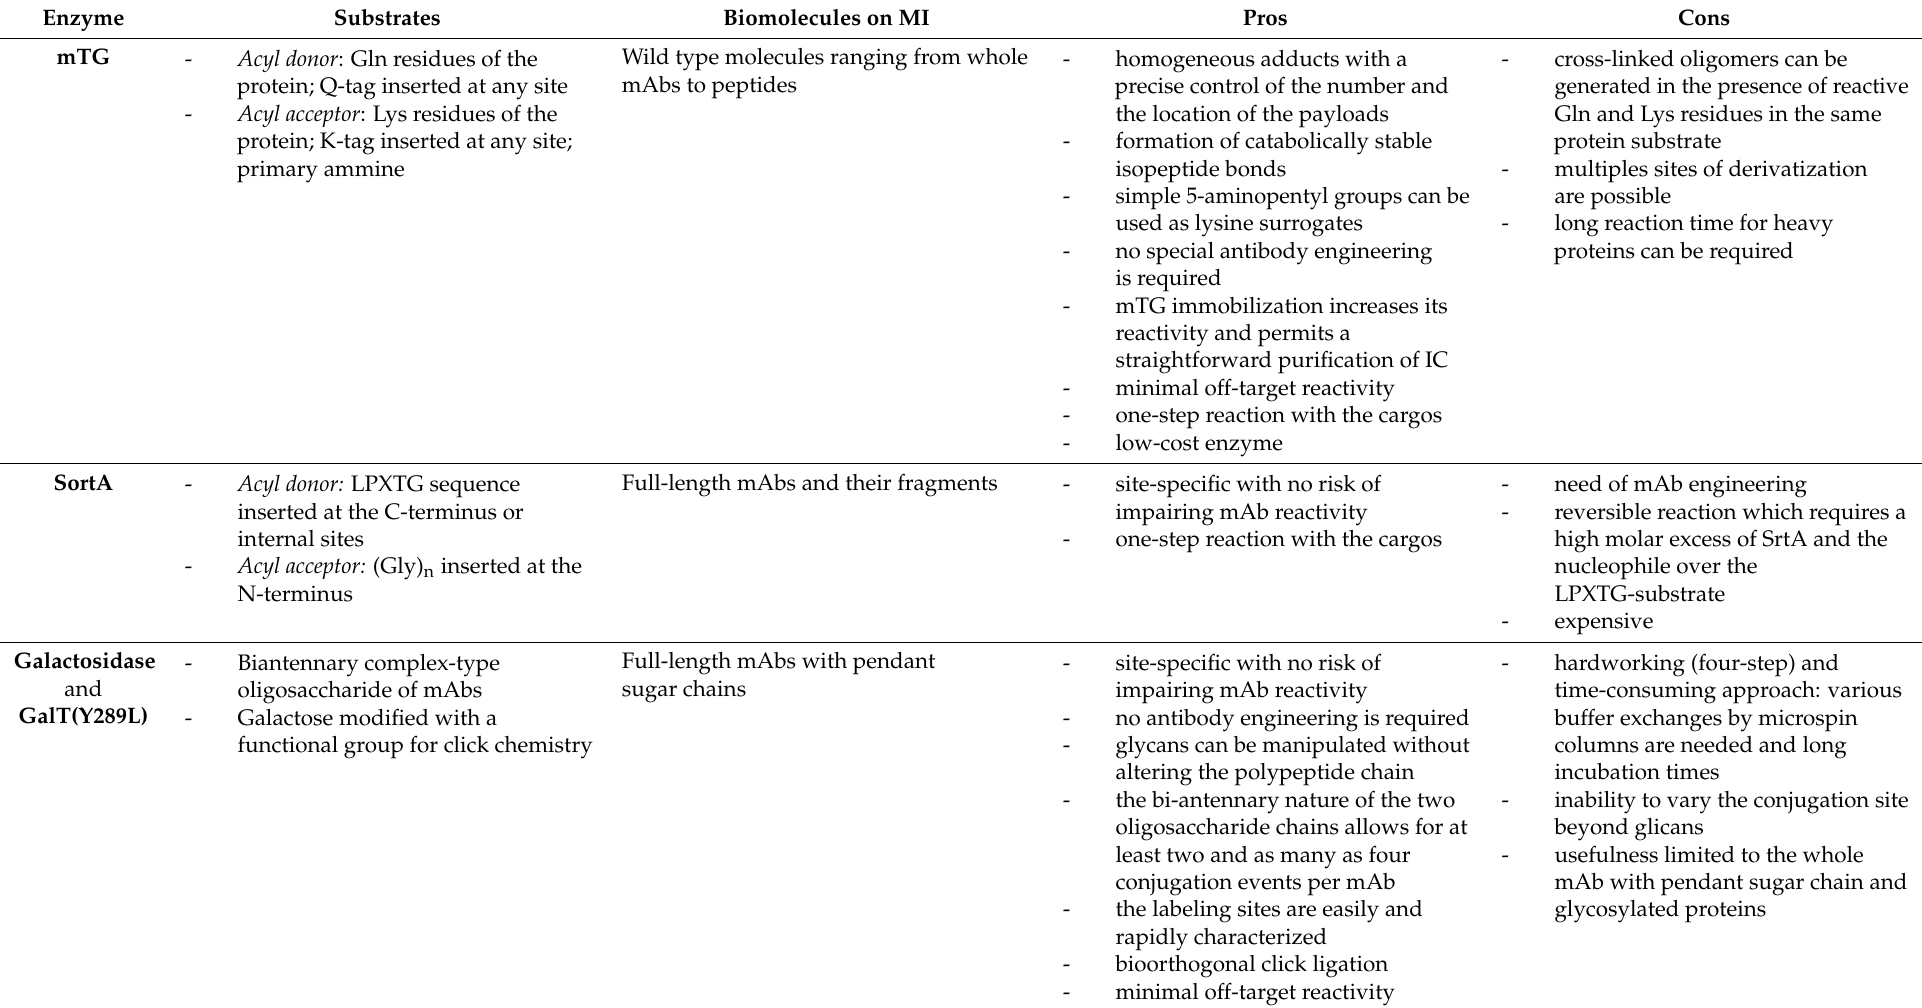
Table 9. Pros and cons of the discussed enzyme-based